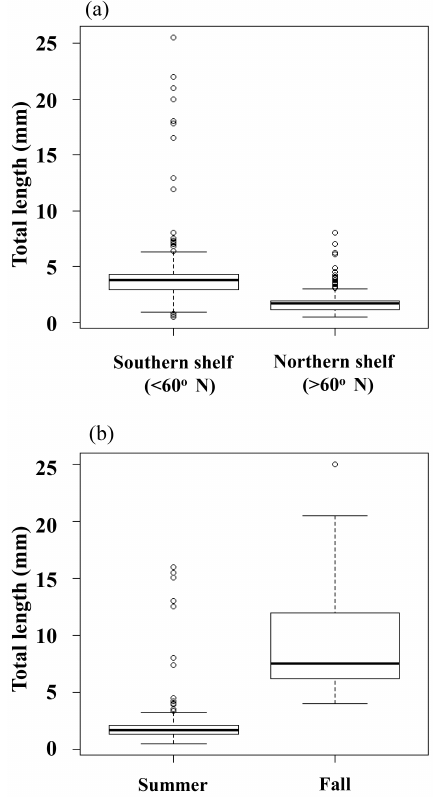
Figure 4. Regional changes (southern shelf <60 ◦ N, northern shelf >60 ◦ N) in the total length (from the tip of the rostrum to the pos- terior end of the telson) of krill in the Bering Sea during summer 2007, 2008, and 2013 (pooled across years, a ), as well as in the Chukchi Sea during fall 2012 and summer 2013 (b)